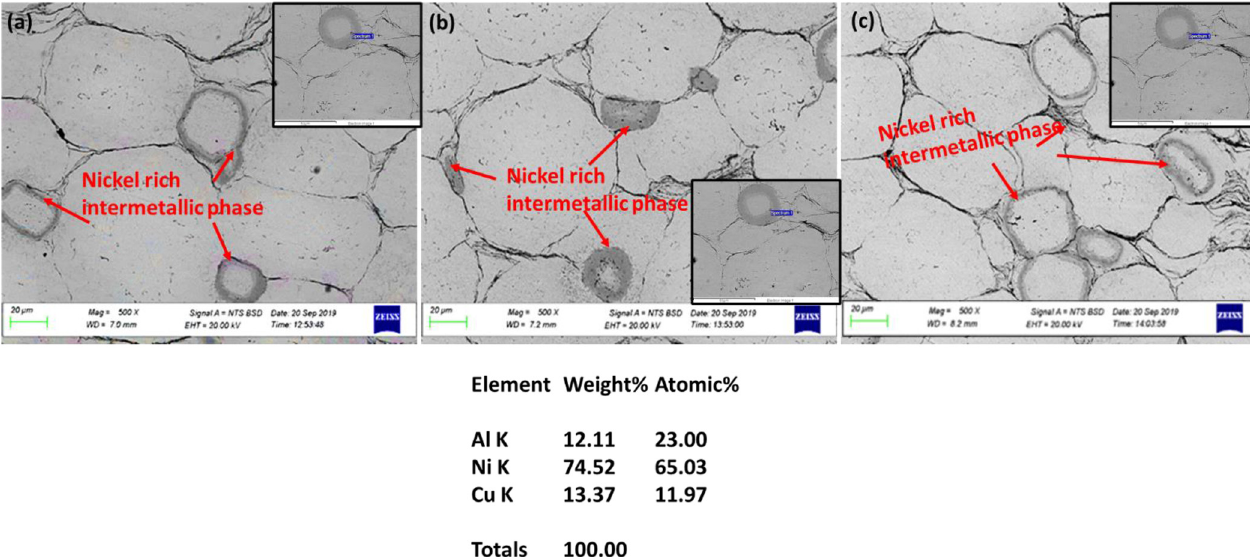
Fig. 3. SEM micrograph of the sintered NAB alloys which consist of Aluminium (a) 6wt.%, (b) 8 wt.%, and (c) 10wt.% alongside the accompanied EDS results to show the composition of the Nickel rich intermetallic phases